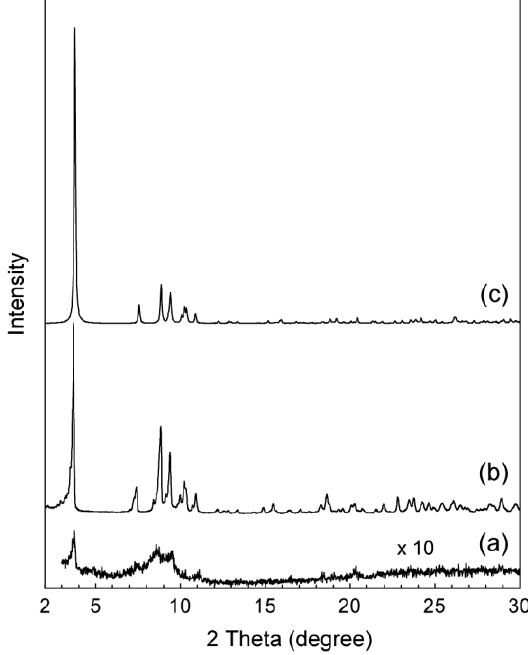
3. Powder X-ray diffraction patterns of ( a ) as-prepared C ( b ) recrystallized C py-W , and that ( c ) calculated with single crystal 16 10